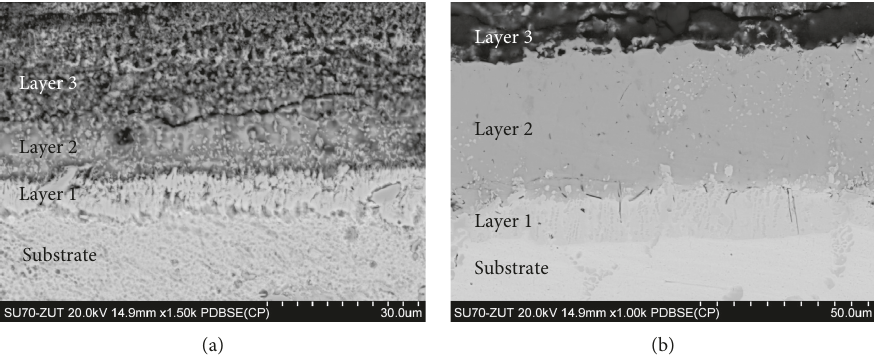
Figure 3: Microstructure (BEI) of Al–Si coating on sample (a) number 7 (technological parameters: 800 ° C, 10 h, Al/Si � 12) and (b) number 2 (technological parameters: 1000 ° C, 5h, Al/Si �